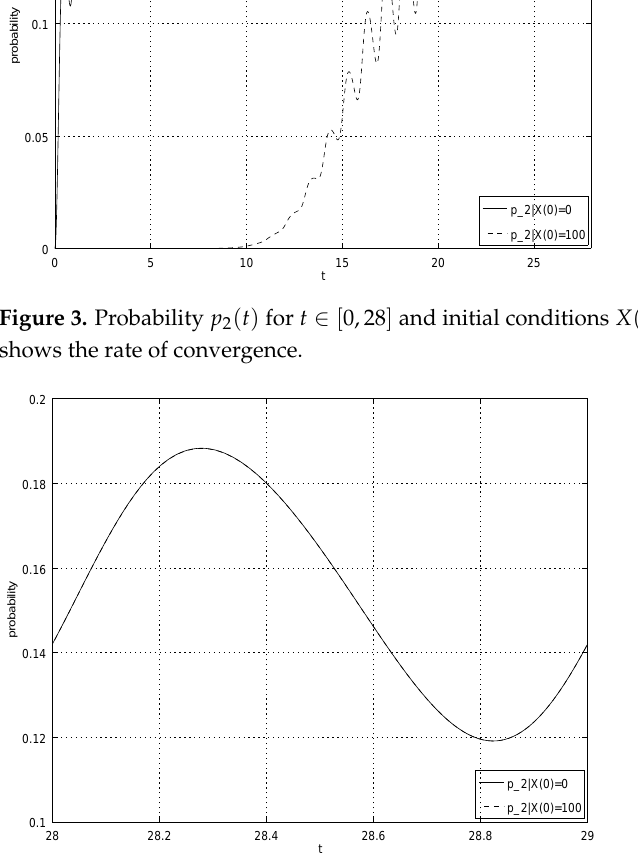
Figure 4. Probability p 2 ( t ) for t ∈ [ 28,29 ] and initial conditions X ( 0 ) = 0 and X ( 0 ) = 100; this figure shows approximation of the limiting probability p 2 ( t )